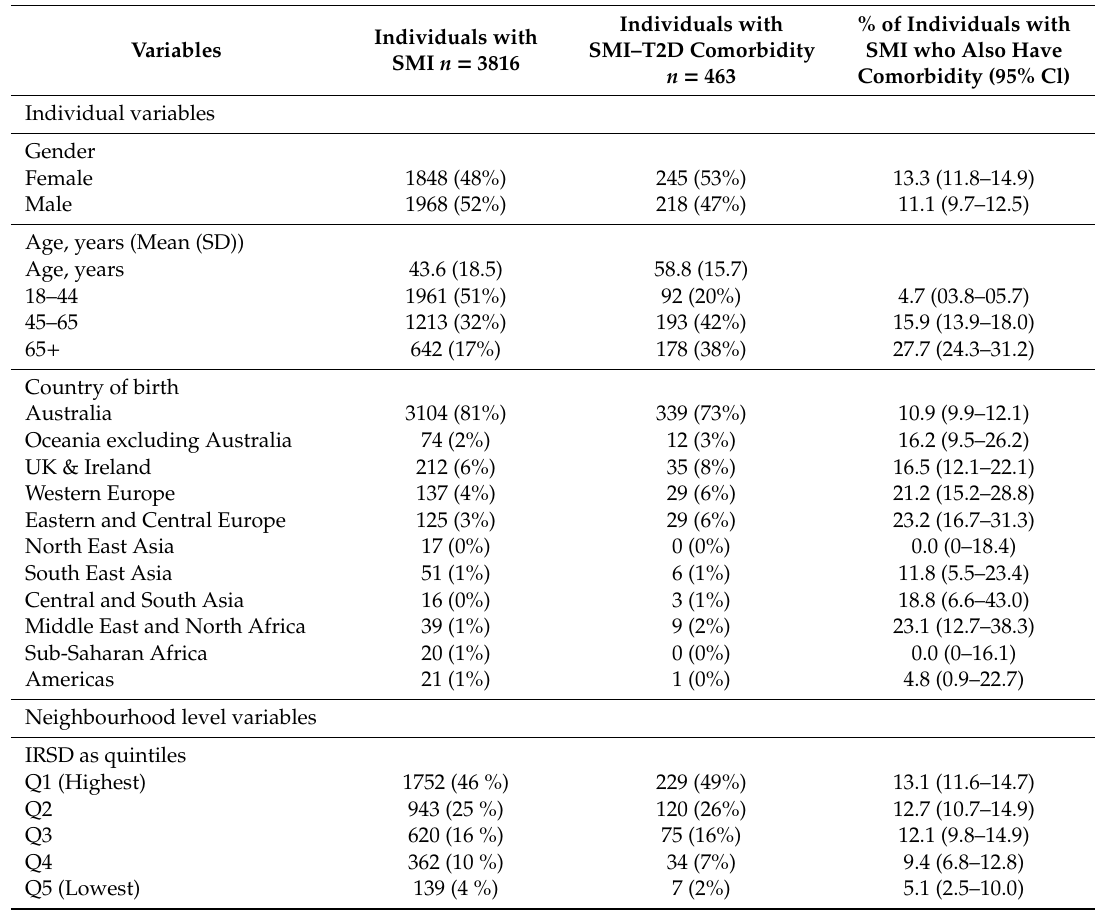
Table 1. Characteristics of study population